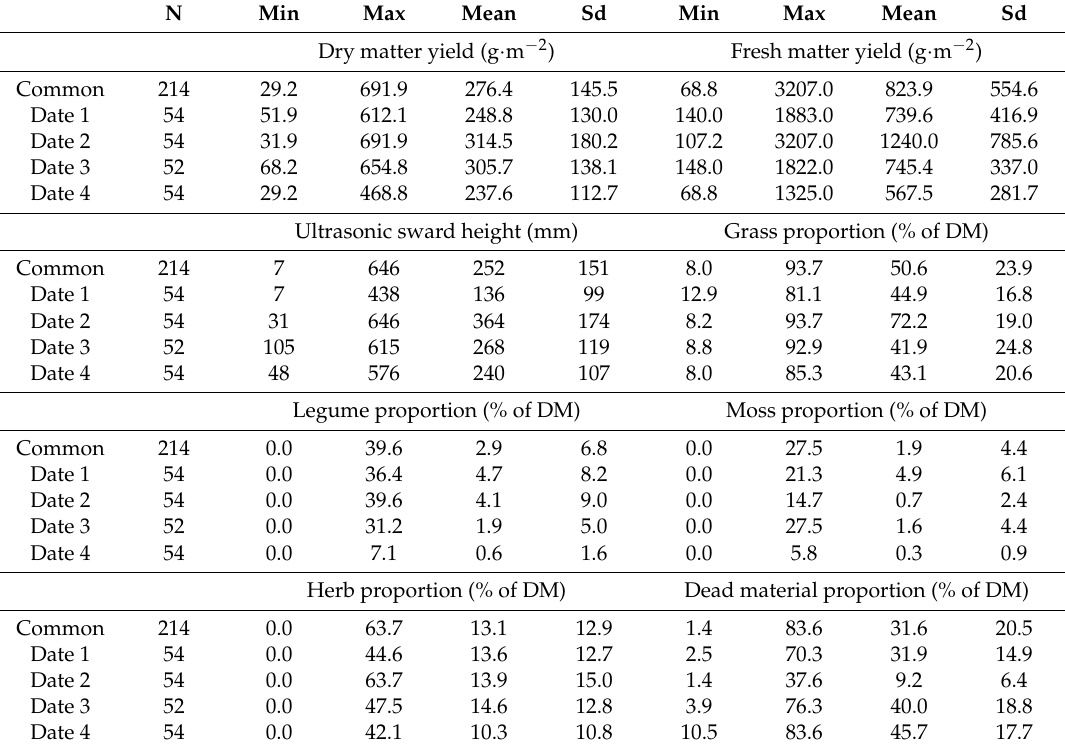
Table 1. Descriptive statistics of dry matter yield, fresh matter yield, ultrasonic sward height and proportion of mosses, grasses, legumes, herbs and dead materials for common and date-specific swards. N Min Max